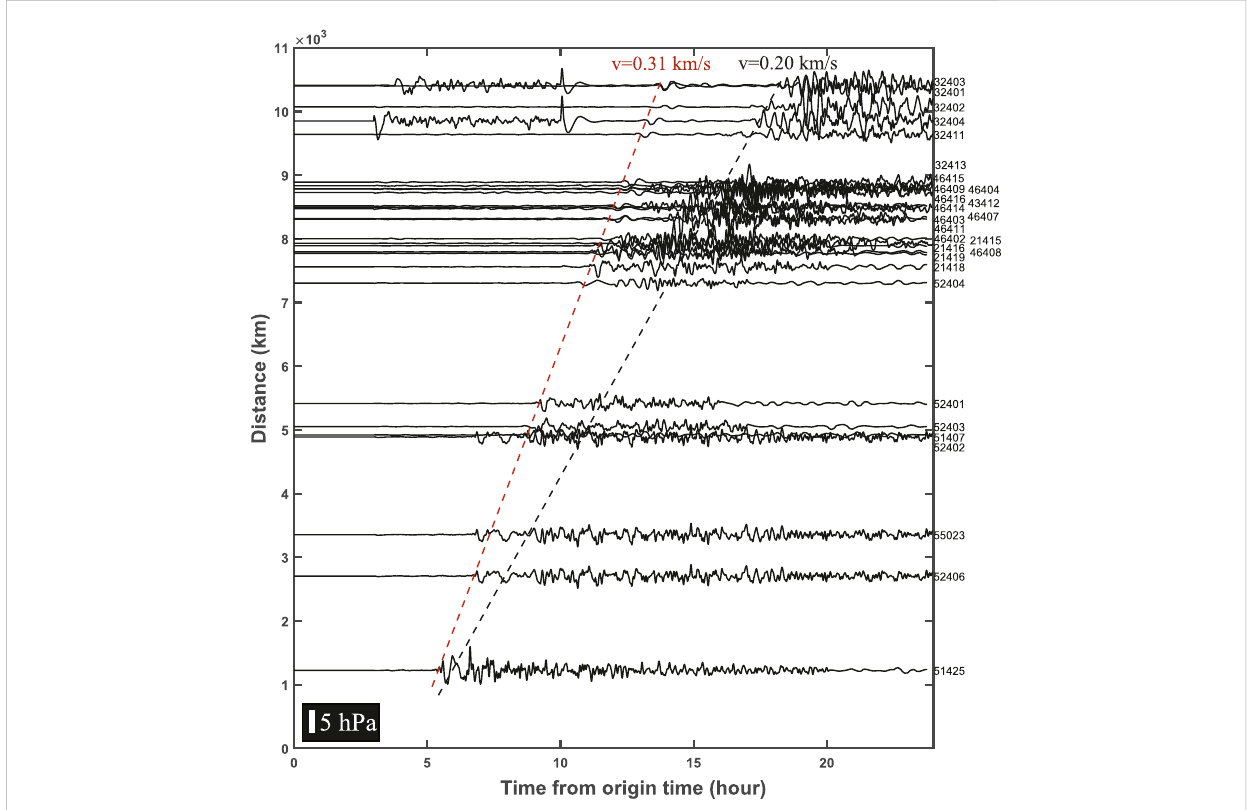
FIGURE 5 Recordsectionofocean-bottompressurerecordedbyDARTsensorswithacontinuousrecordingof24 haftertheeruptionorigintime.Waveforms are bandpass fi ltered from 0.0001 to 0.005 Hz. The infrasound wave has an apparent velocity of 0.31 km/s. The waves with an apparent velocity of 0.20 km/s, which arrived up to 5 hours after the infrasound at 10,000 km, is a shallow-water gravity wave.